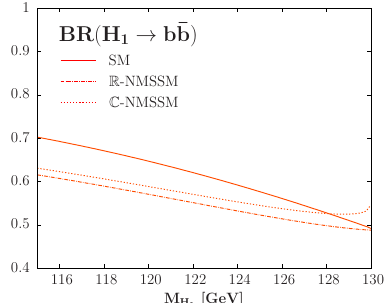
Figure 4. The decay branching fraction of the lightest Higgs state H 1 into b ¯ b as a function of the Higgs mass M H The full line is the SM prediction, the dashed-dotted line is the R –NMSSM prediction and the dotted line is the C –NMSSM pre- diction.